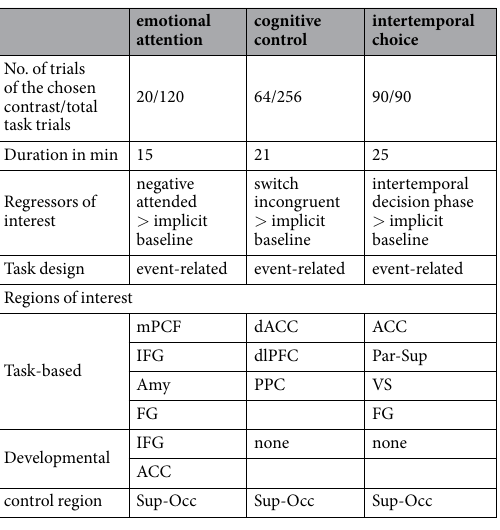
Table 3. Overview of task characteristics. Note . mPFC – medial prefrontal cortex, IFG – inferior frontal gyrus, Amy – Amygdala, FG – fusiform gyrus, ACC – anterior cingulate cortex, Sup-Occ – superior occipital lobe, dACC – dorsal anterior cingulate cortex, dlPFC – dorsolateral prefrontal cortex, PPC – posterior parietal cortex, Par-Sup – superior parietal lobe, VS – ventral